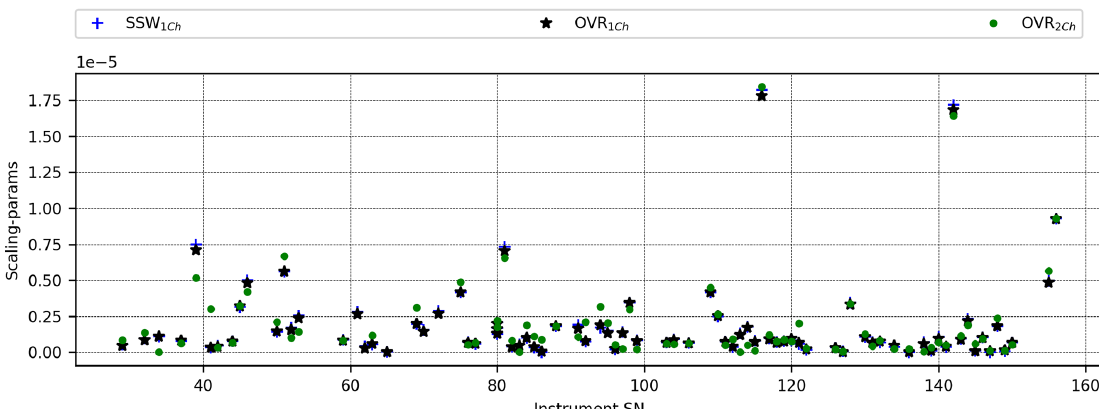
Figure 13. Instrumental variation in the spectral scaling factors in each of the spectral windows used and for both channels.